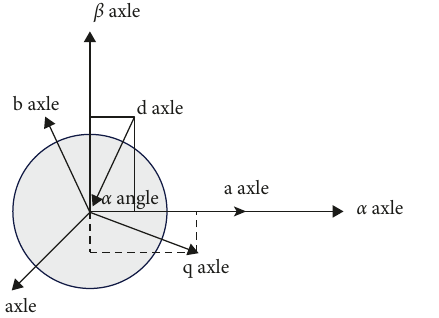
Figure 4: Inverter